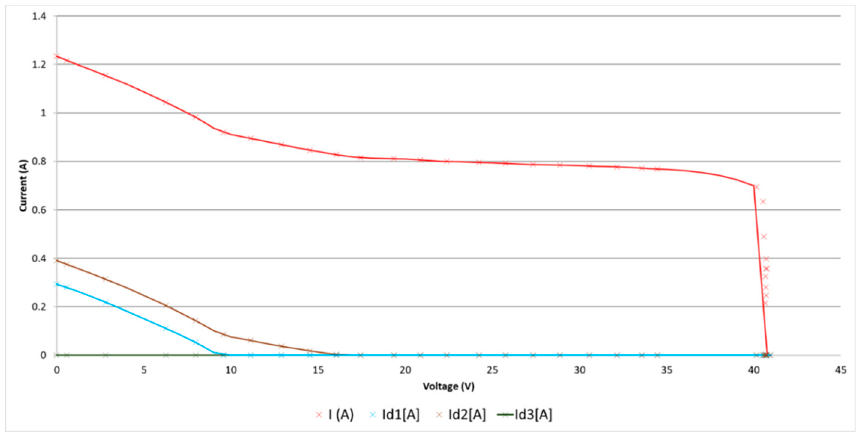
Figure 7. Experimental monocrystalline solar module I–V characteristic curve in condition 4.